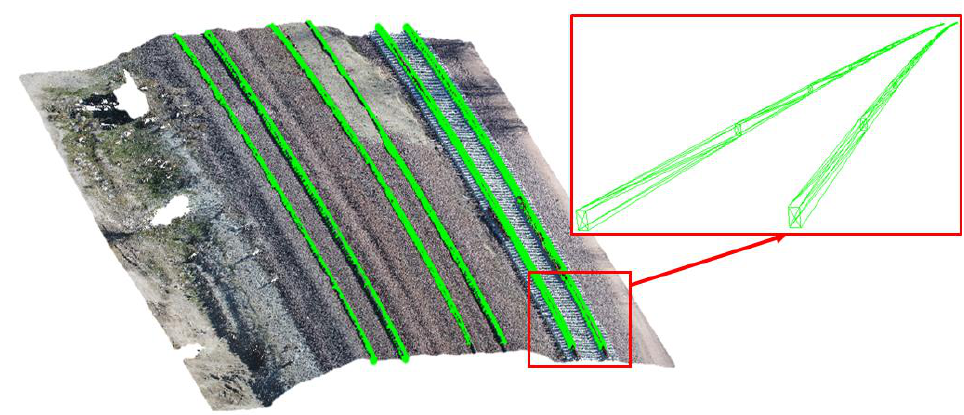
Figure 9. Final 3D model of rail tracks overlaid on the point cloud.